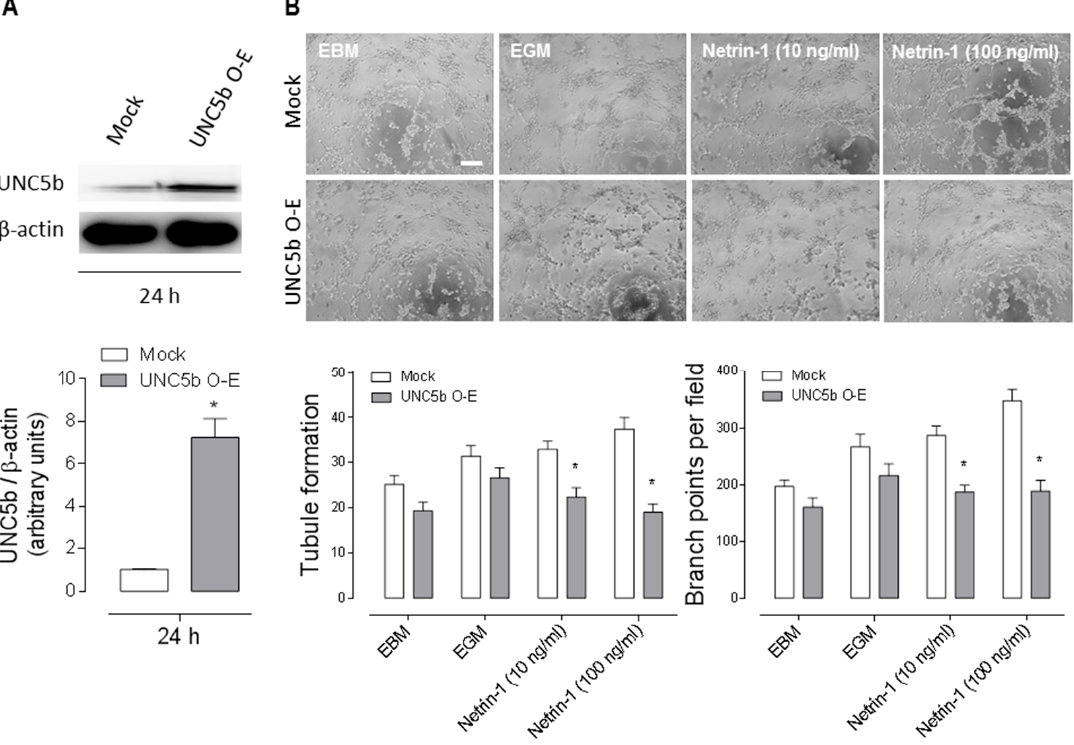
Figure 4. Overexpression of the anti-angiogenic receptor UNC5b prevents the pro-angiogenic response of Netrin-1 in HUVEC. Healthy HUVEC were transfected with UNC5b O-E or Mock-expressing constructs (1 µg/well) ( A ) To confirm UNC5b overexpression, cell lysates were analysed by Western Blot. β -actin levels were determined as loading control. Data correspond to the mean ± S.E.M (healthy n = 3). * p < 0.05 vs. internal control. ( B ) The overexpression of UNC5b was evaluated through a 4 h of Matrigel tubule formation assay in presence of Netrin-1. Representative images of treatments as indicated. Data correspond to the mean ± S.E.M (healthy n = 3). Scale bar = 15 µm. * p < 0.05 vs. internal control.